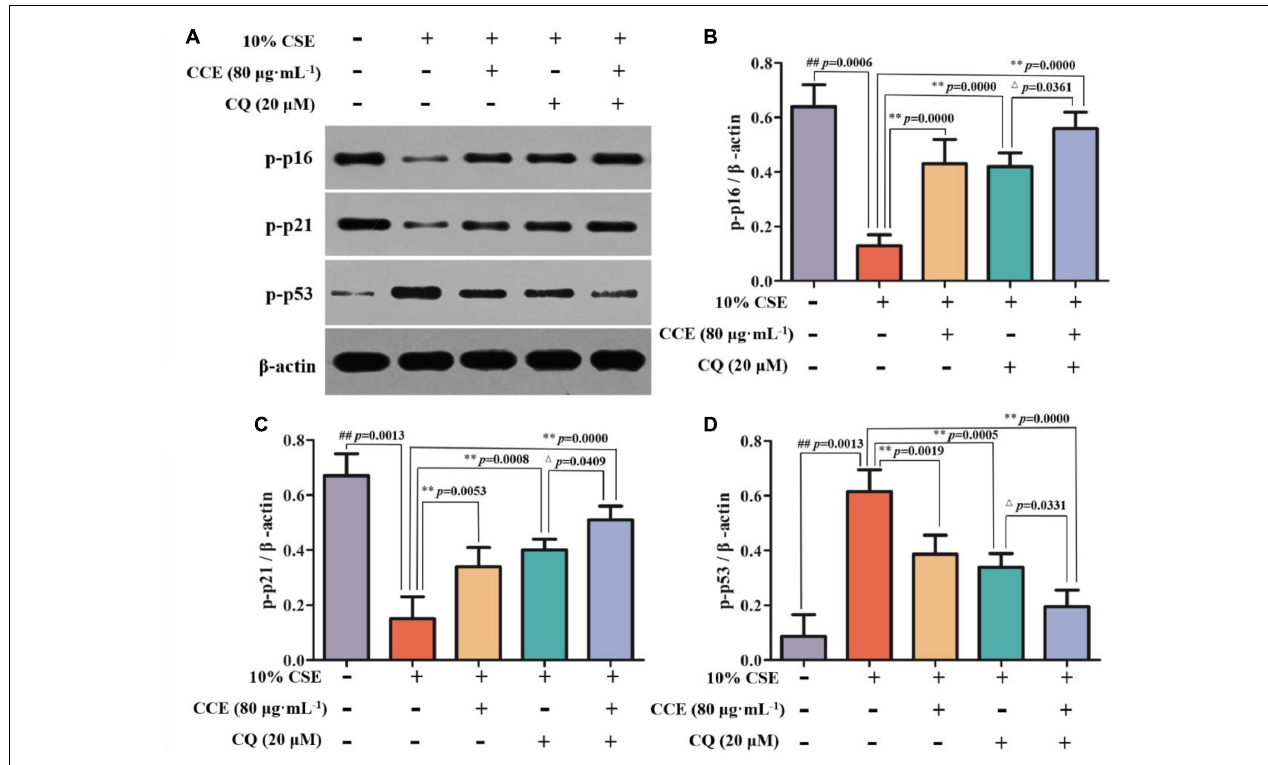
FIGURE 8 | Effects of CCE on the phosphorylation levels of p-p16 (B) , p-p21 (C) and p-p53 (D) in the presence of autophagy inhibitor CQ (A) . Data are expressed as means ± SD ( n = 3). ## p < 0.01, vs. the blank control; ∗∗ p < 0.01, vs. 10% CSE; (cid:52) p < 0.05, vs. 20 µ M